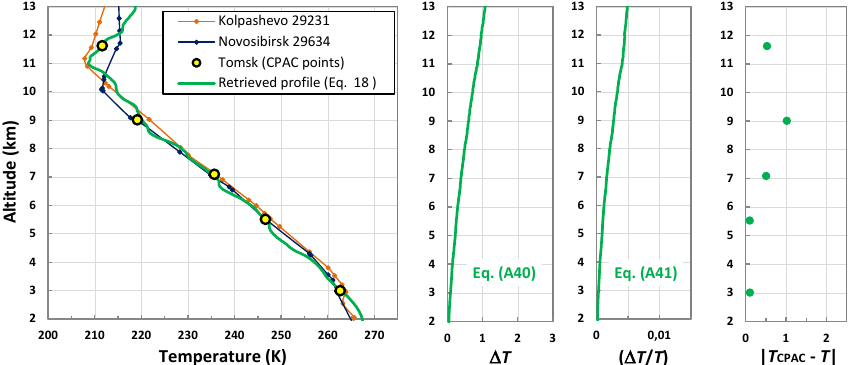
Figure 8. (1 April 2015) Temperature profile retrieved using the temperature retrieval function (Eq. 18) derived from the calibration function suggested by Lee III (2013). The uncertainties (cid:49) T and ( (cid:49) T / T ) are calculated by Eqs. (A40) and (A41),